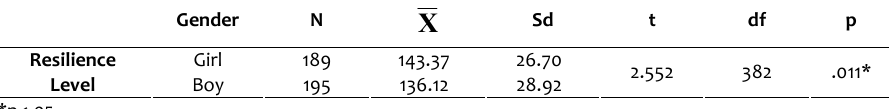
Table 3. Results of T-Test Analysis on Resilience Levels of the 5-Year-Old Preschoolers based on Gender Gender